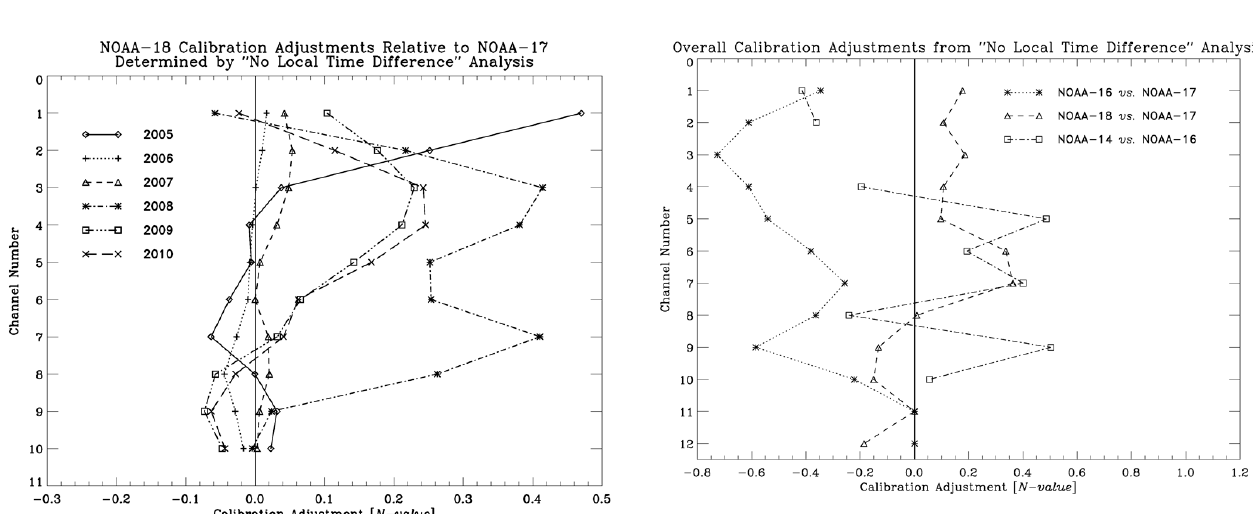
Fig. 8. NOAA-18 calibration adjustments as a function of wave- length relative to NOAA-17 for the years 2005–2010, as determined using the “no local time difference” (NLTD) method. Coincident profiles used for this analysis were taken within 1.5 ◦ latitude and 30min of each other, and have no more than 1.5 DU difference in total ozone value.